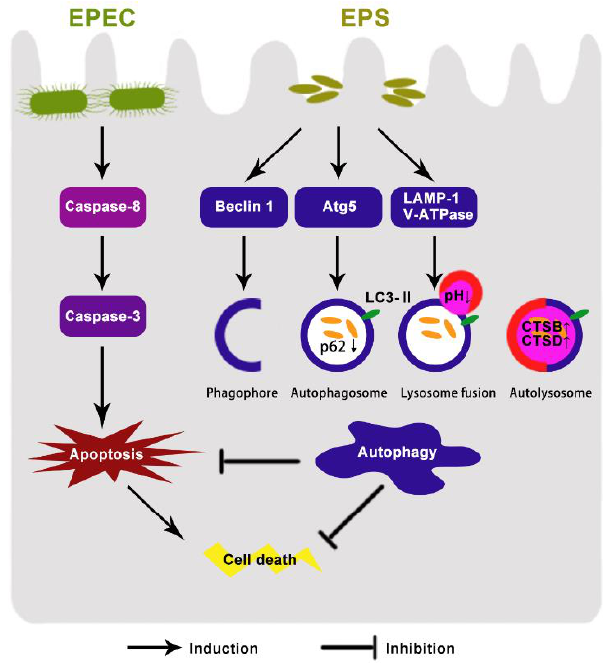
Figure 6. Proposed model of the protective effect of B. lactis EPS in EPEC-induced cell damage. EPEC results in impaired autophagy and apoptosis. B. lactis EPS promotes autophagosome formation by up-regulating the expressions of proteins Beclin 1, ATG5 and LC3-II and enhances lysosomal function to accelerate autophagosome degradation. B. lactis EPS inhibits apoptosis via decreasing the expressions of the apoptotic proteins caspase-8 and caspase-3. Through this mechanism, B. lactis EPS protects against EPEC-induced apoptotic cell death.